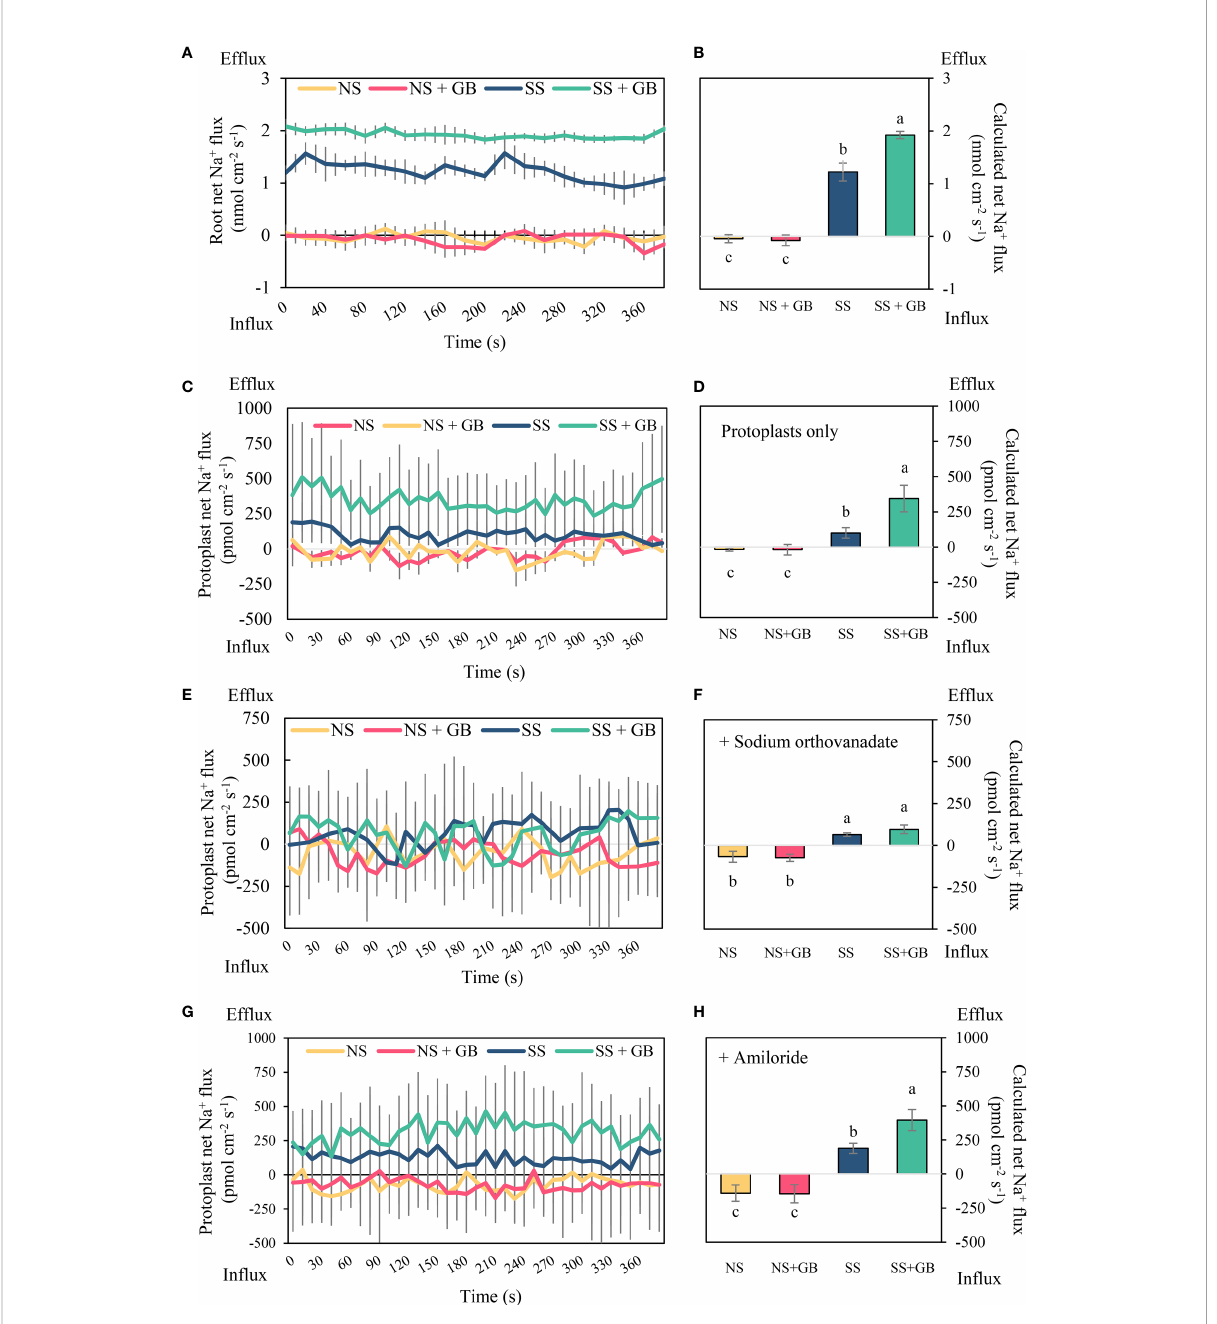
FIGURE 4 Effects of GB on Na + fl ux in roots and protoplasts with membrane ion transporter inhibitors under non-stressed (NS) and salinity-stressed (SS) conditions. (A) Real-time net fl ux of Na + in roots and (B) corresponding calculated mean Na + fl ux rates during measurement period. (C) Real- time net Na + fl ux in leaf protoplasts and (D) corresponding calculated mean Na + fl ux rates during measurement period. (E) Real-time net Na + fl ux in leaf protoplasts with sodium orthovanadate treatment, and (F) corresponding calculated mean Na + fl ux rates during measurement period. (G) Real-time net Na + fl ux in leaf protoplasts with amiloride treatment, and (H) corresponding calculated mean Na + fl ux rates during measurement period. The values indicate the mean, while the vertical error bars indicate the standard deviation (n = 5). The different letters in each panel represent signi fi cant differences determined with Fisher ’ s protected LSD test at P <